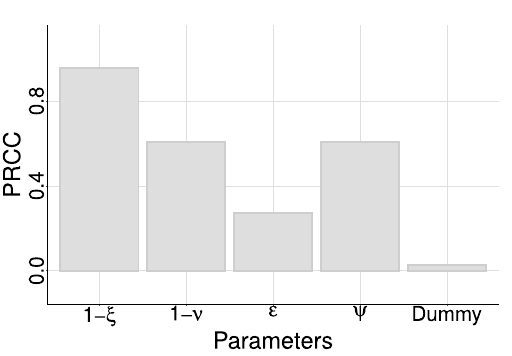
Figure 5. Sensitivity analysis using control efficacy as the output. A negative-control (dummy-parameter) was used to assign a zero value for a sensitivity index. Parameters values below the dummy are considered as not contributing to the model output. The result corresponds to the city of Sobral-CE, but the rank is obtained for the other